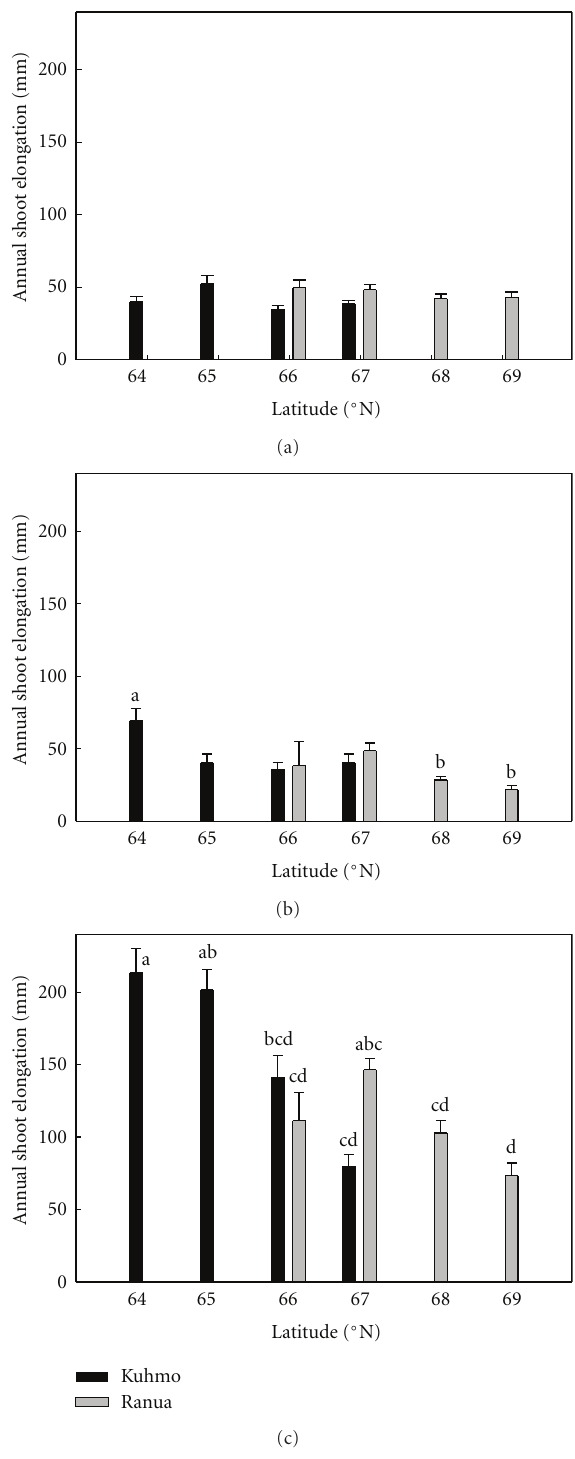
Figure 4: Annual shoot elongation of the Scots pine seedlings (mean ± SE, n = 20, except for 2000 n = 20) in (a) 1998, (b) 1999 and (c) 2000. Di ff erent letters indicate di ff erence at P < . 05.